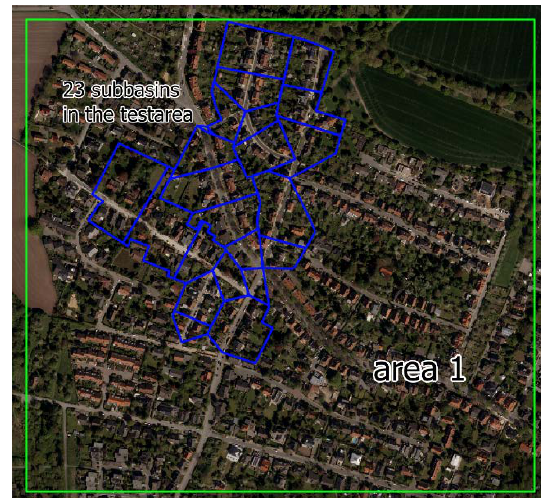
Figure 2. The study catchment with 23 subbasins (blue) in area 1 (green